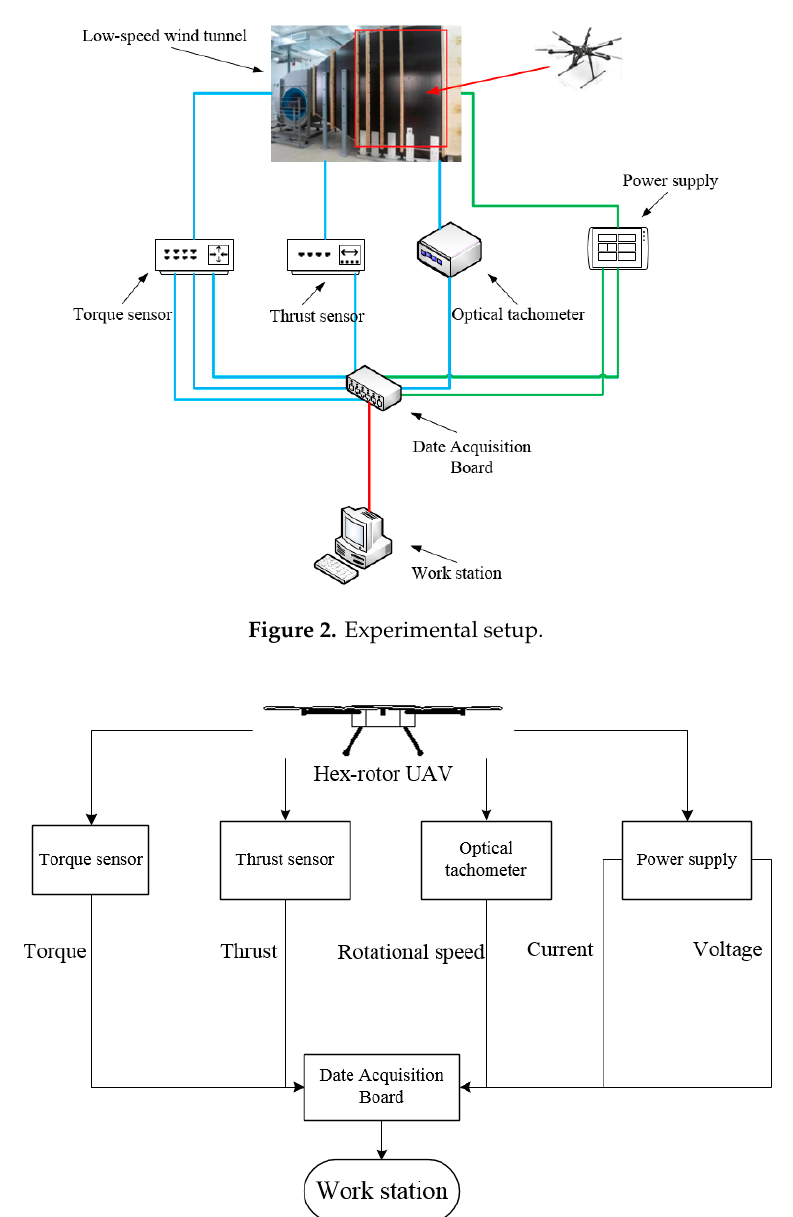
Figure 3. Sketch of the signal process.